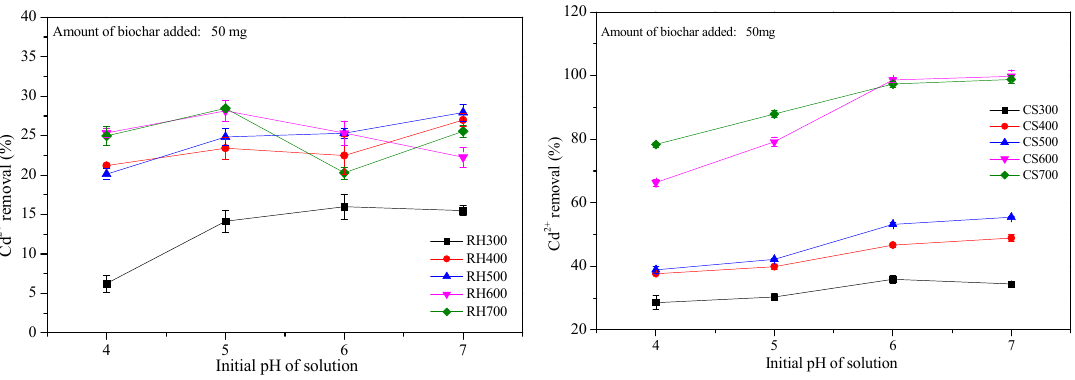
Figure 4. Effects of the solution pH on Cd 2+ removal. Notes: RH300, RH400, RE500, RH600, and RH700 indicate that rice husk were pyrolyzed at 300, 400, 500, 600 and 700 °C, respectively; CS300, CS400, CS500, CS600, and CS700 indicate that cotton straw were pyrolyzed at 300, 400, 500, 600 and 700 °C, respectively.